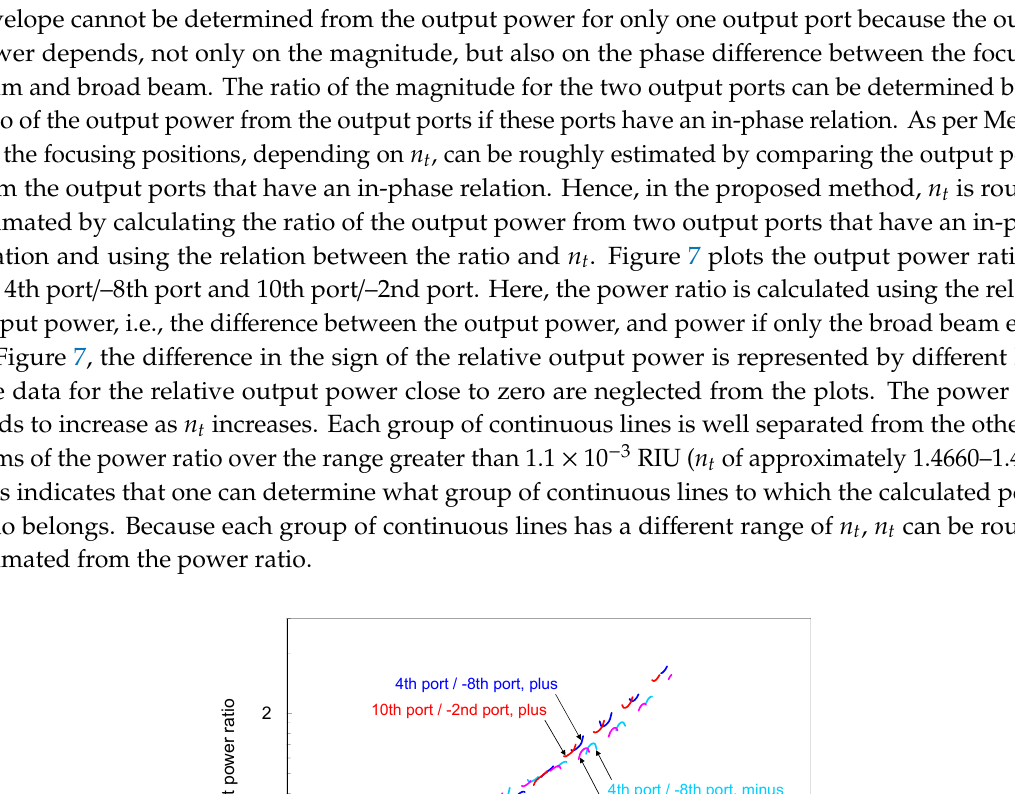
Figure 8. Phase calculated from –8th port/–2nd port and 4th port/10th port as a function of n t .